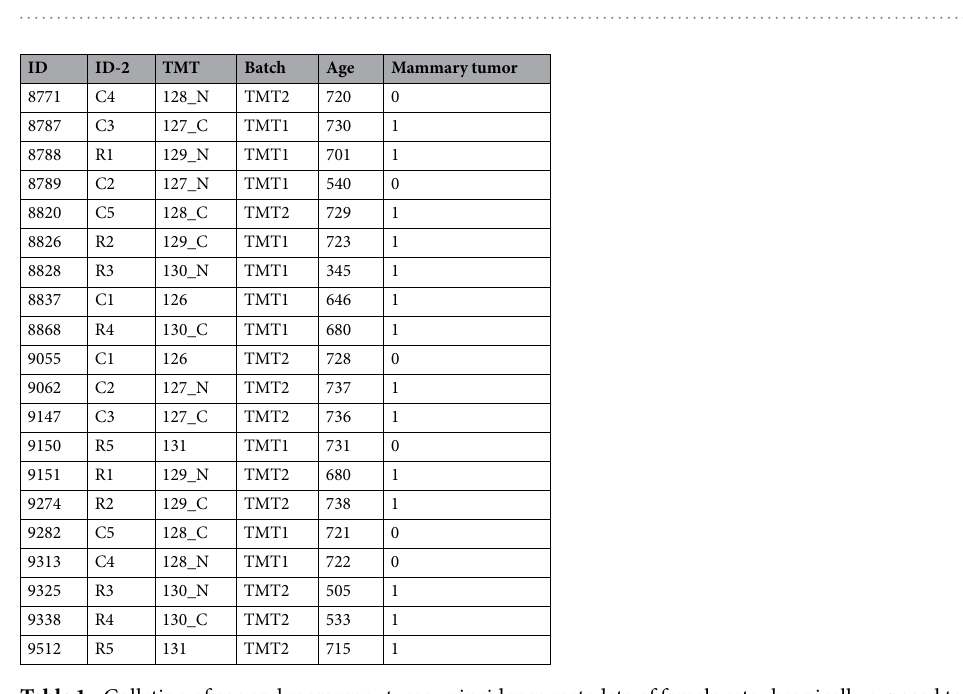
Table 1. Collation of age and mammary tumour incidence metadata of female rats chronically exposed to Roundup herbicide. Column ID refers to the identification number of animals in Reference 29. ID-2, TMT and Batch refers to the same animal as described in this Article. Mammary tumor incidence is from Reference